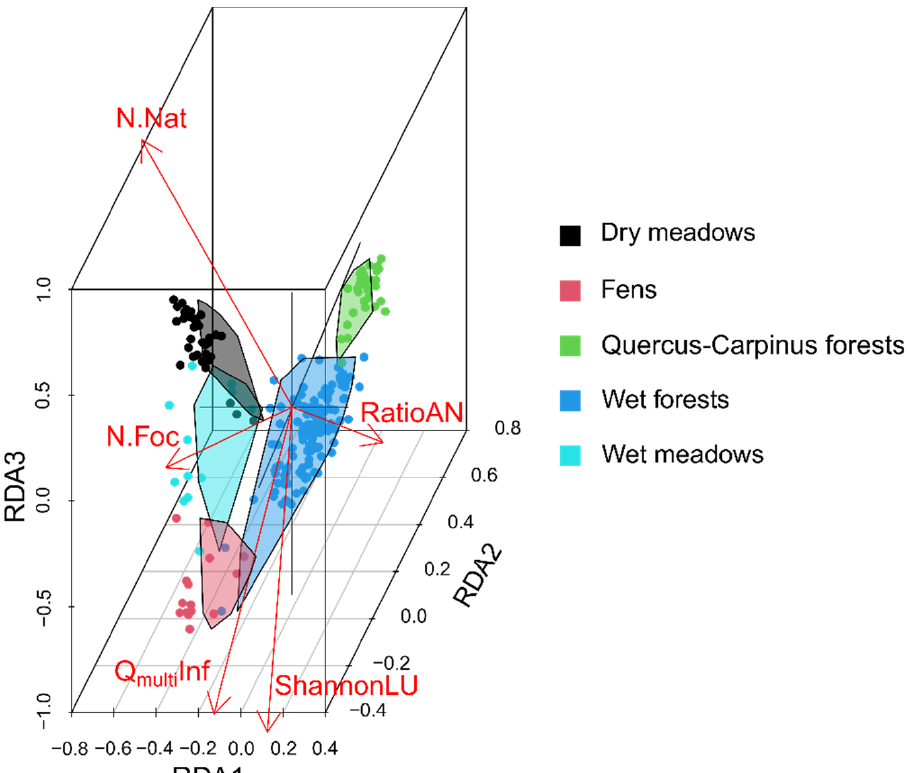
Figure 4. tb-RDA ordination based on Hellinger pre-transformed species composition matrix, with site grouped per habitat and displaying the following variables: focal species richness (N.Foc), native species richness (N.Nat), Rao’s Q index, calculated from the 10 bands of the Sentinel 2 image of 3 June 2019 with the weight for the distance matrix set to infinite (Q multi INF), and ratio of alien to native species richness (RatioAN), Shannon index on land use diversity (ShannonLU).